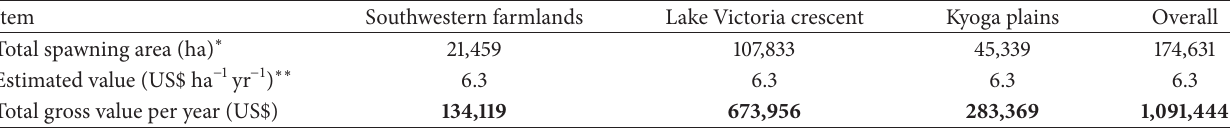
Table 2: Monetary value of fish spawning grounds in the wetlands of Uganda.